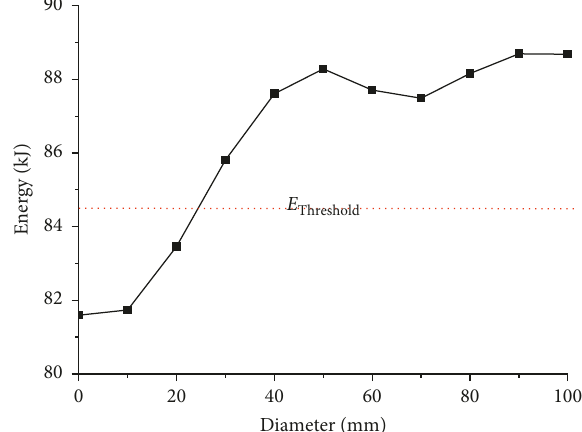
Figure 19: Changing curve of difference between maximum kinetic energy and air energy with different vent